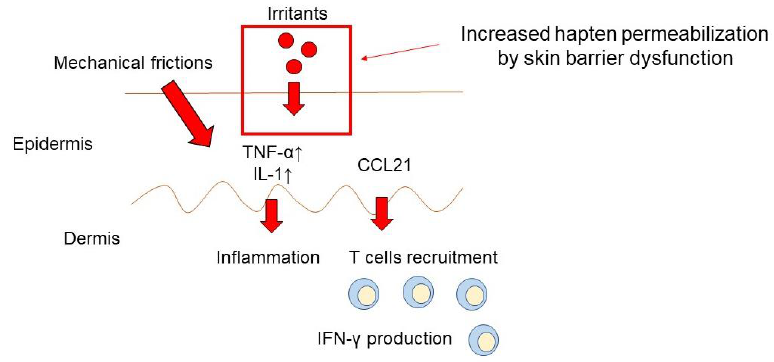
Figure 1. The pathogenesis of irritant contact dermatitis.